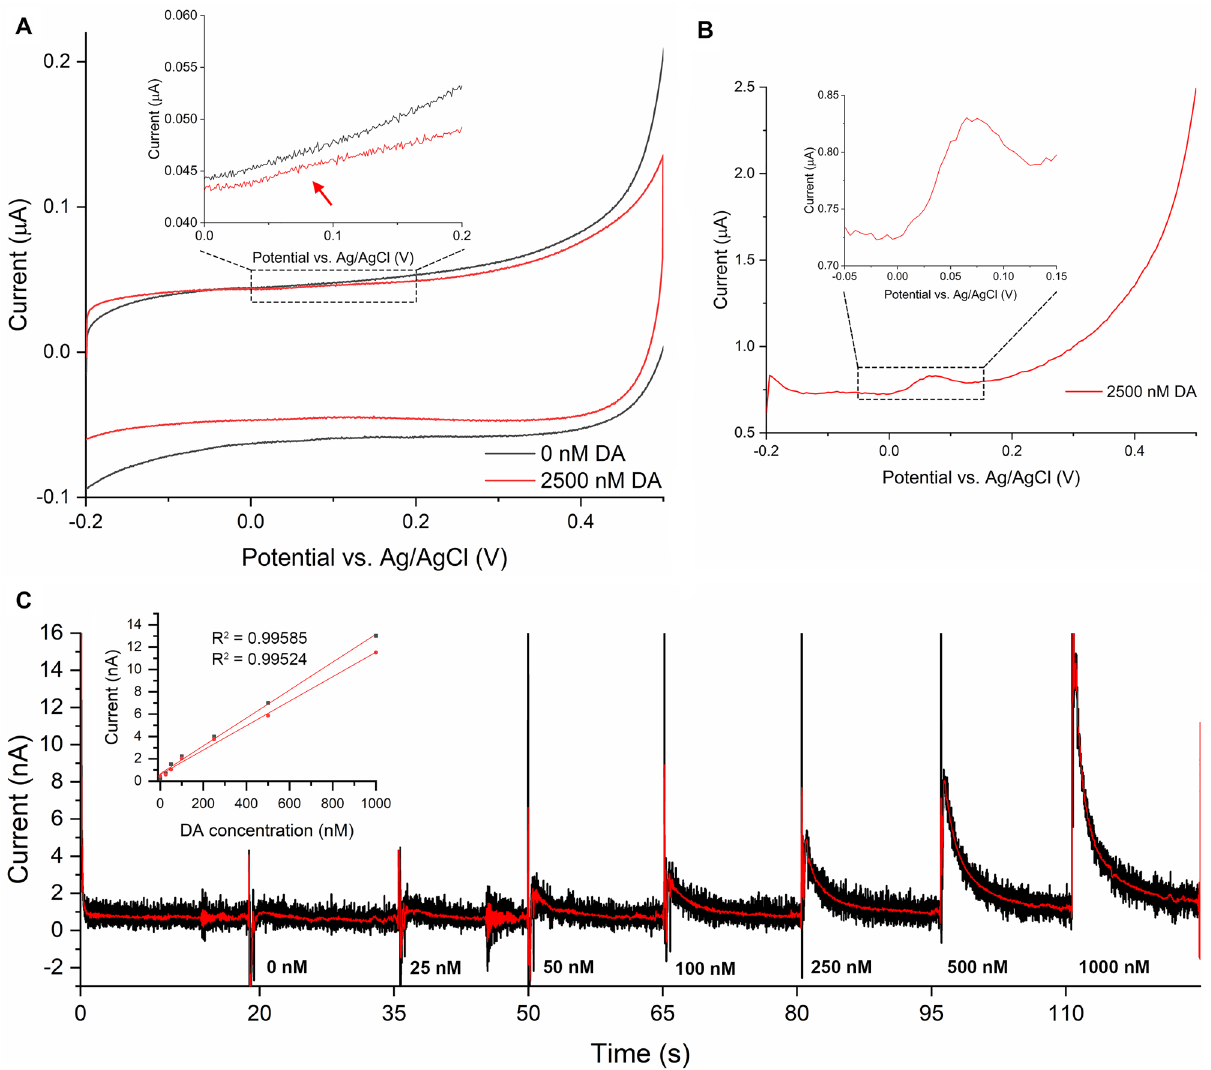
Figure 2. Dopamine at concentrations of 25–1000 nM can be detected from organoid medium that initially contained 200 μM AA, as is shown with SWCNT electrodes. While the oxidation peak was barely visible with CV at 2500 nM dopamine (DA) concentration ( A ), SWV evidently showed DA oxidation peak at 82 mV (vs. 2 Ag/AgCl) potential ( B ). Fully linear current-concentration relationship ( R > 0.995) was obtained for DA in organoid medium ( C ), illustrating that DA can be chronoamperometrically detected with high sensitivity despite the initial presence of AA at high concentration. FFT-filtering was used (red trace in C ) to filter out noise and thus make the trace more illustrative. Ringing noise that is most visible prior to 0 and 50 nM DA solution injections was caused when the pipette tip was brought into potential in order to determine holding potential for chronoamperometry. In chronoamperometry, we injected 10 μL of organoid medium that contained only very minor amounts (25–1000 nM) of freshly added dopamine, causing the concentration of dopamine to decrease rapidly as it diffuses out from electrode surface. Although the slope of linear fit deviated slightly between two measurements (Fig. 2C inlet), we must emphasize here that injections of 10 μL volume were done manually and thus both the vicinity of pipette tip to electrode surface but also the injection pressure may deviate slightly between measurements. These deviations can cause minor dif- ferences in the recorded currents between individual experiments. Although dopamine peak potential was at 82 mV, the onset to dopamine oxidation started at 50 mV, as was recorded with CV at 2500 nM concentration (Fig. 2A). For AA, the peak oxidation potential was at 394 mV but onset to AA oxidation started at around 50 mV in culture medium (Supplementary Figs. S4 and S5). Because of this, AA would generate oxidation current at the 125 mV (vs. Ag/AgCl) potential where we kept electrodes during chronoamperometric recording. Thus, AA would interfere dopamine detection because the electrodes were kept submerged in organoid medium during the dopamine injection series. If there was AA present at significant concentration in the medium, we would expect to observe a stable AA oxidation current that would